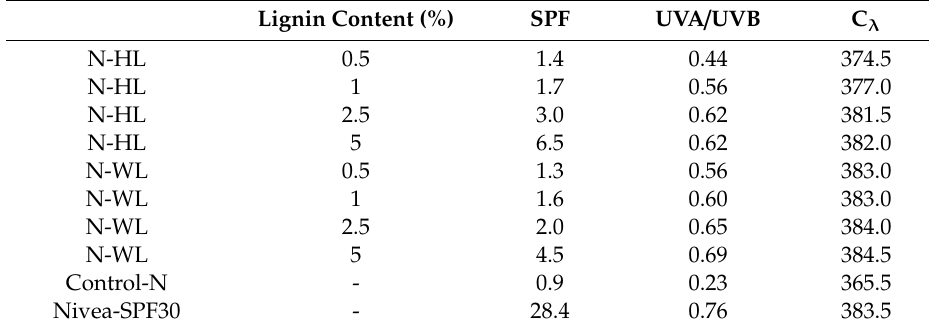
Figure 4. Photograph of the cream with hazelnut lignin addition in di ff erent concentrations. Table 6. SPF, UVA / UVB ratio and critical wavelength values (C λ ) of the pure cream blended with hazelnut and walnut